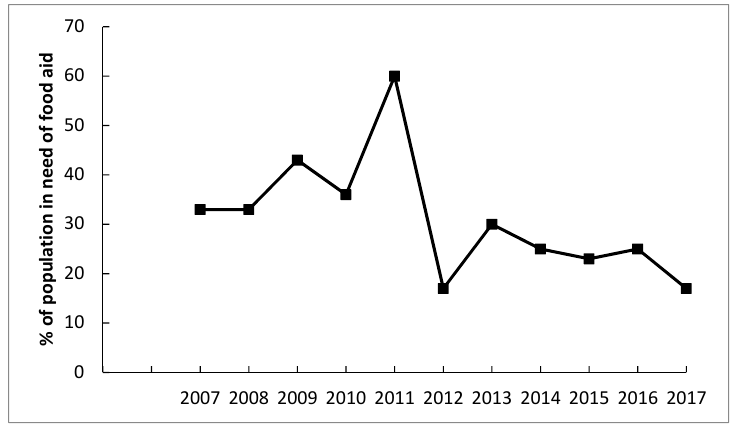
Figure 1. Percentage of population in need of food aid in Turkana 2007–2017 [23].